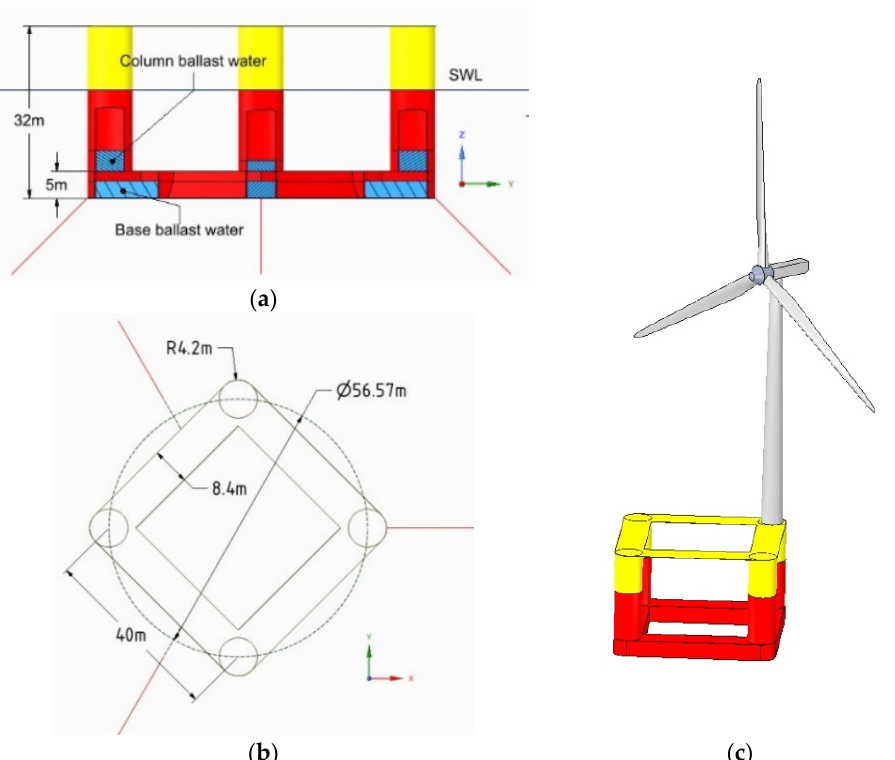
Figure 11. Sketch of four-column platform floating wind turbine system: ( a ) front view of four-column platform; ( b ) top view of four-column platform; ( c ) isometric view of four-column floating wind turbine system.